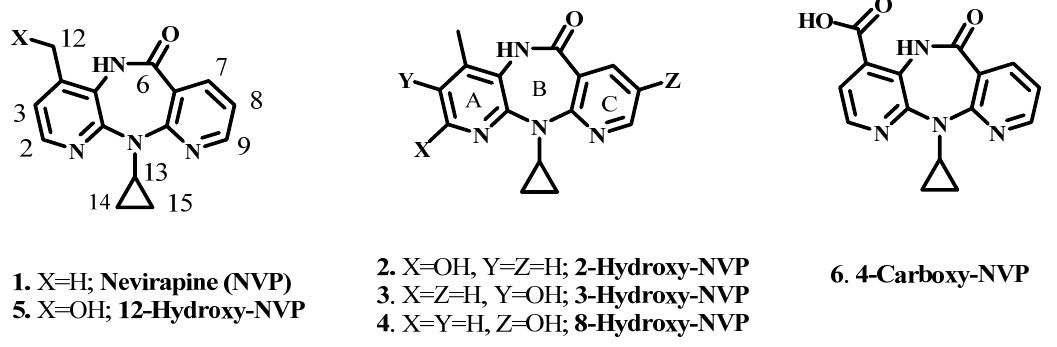
Figure 1. Structures of Nevirapine ( 1 ) and its Phase I